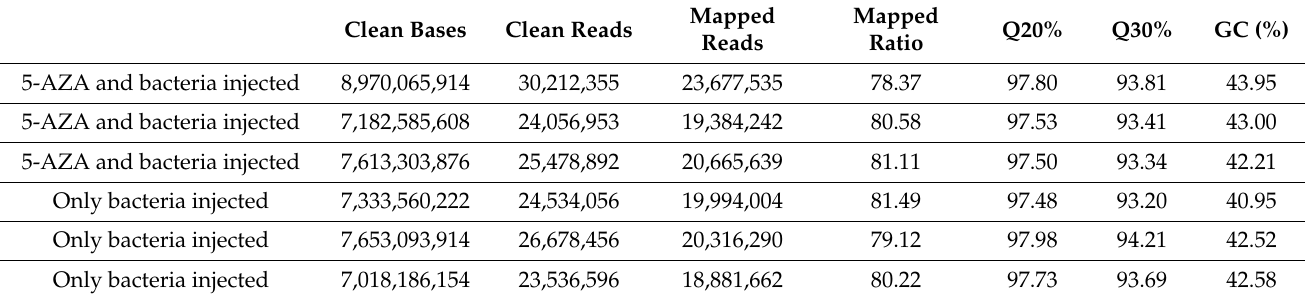
Table 1. Statistical analysis of the transcriptome sequence